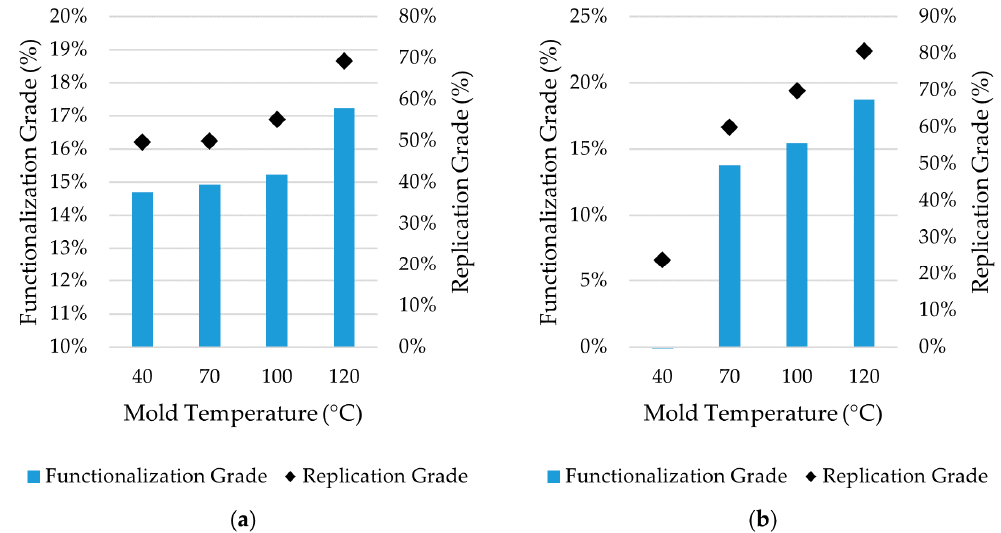
Figure 10. Comparison between polymer surface replication grade and functionalization grade for ( a ) PS parts and ( b ) PMMA parts.